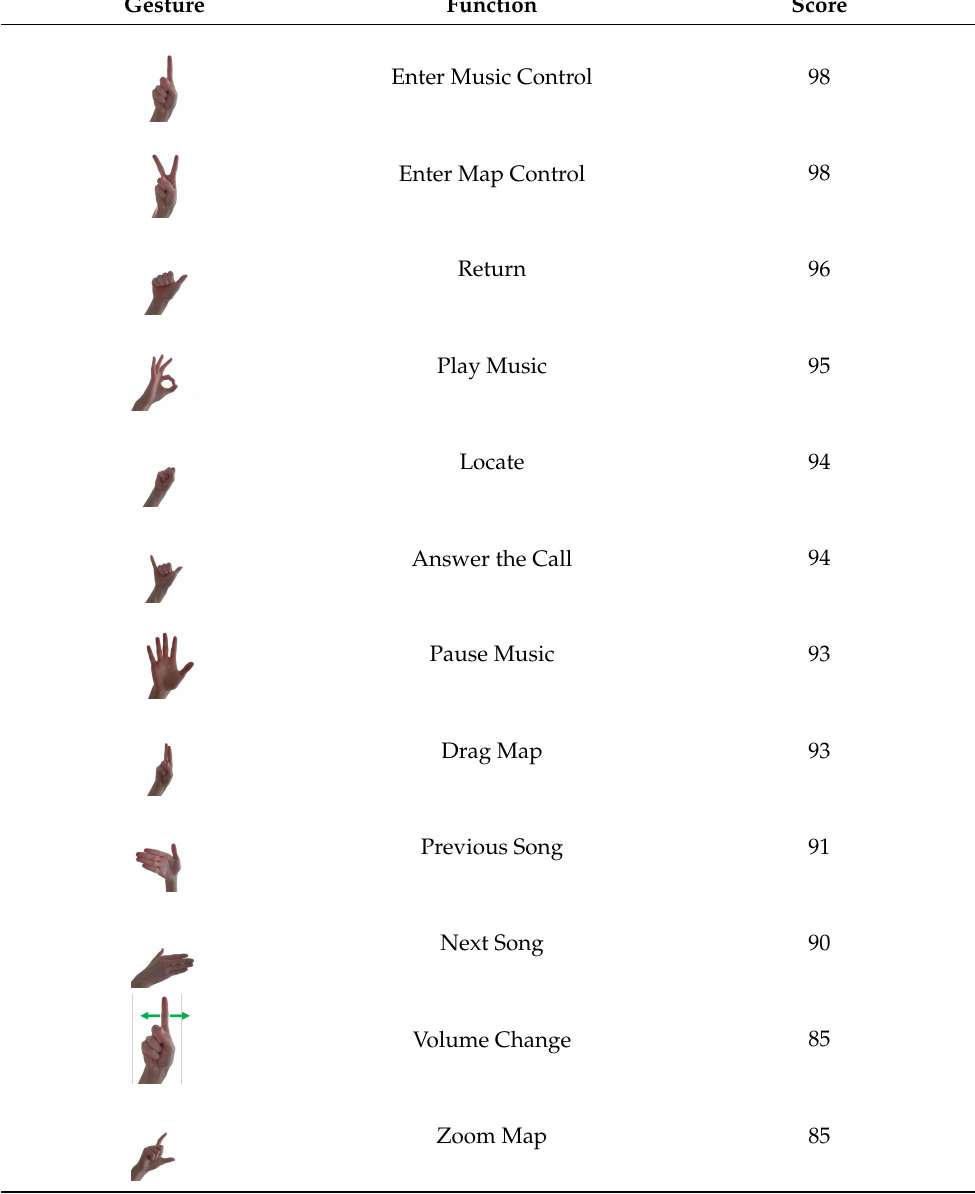
Table 7. Final gestures for the